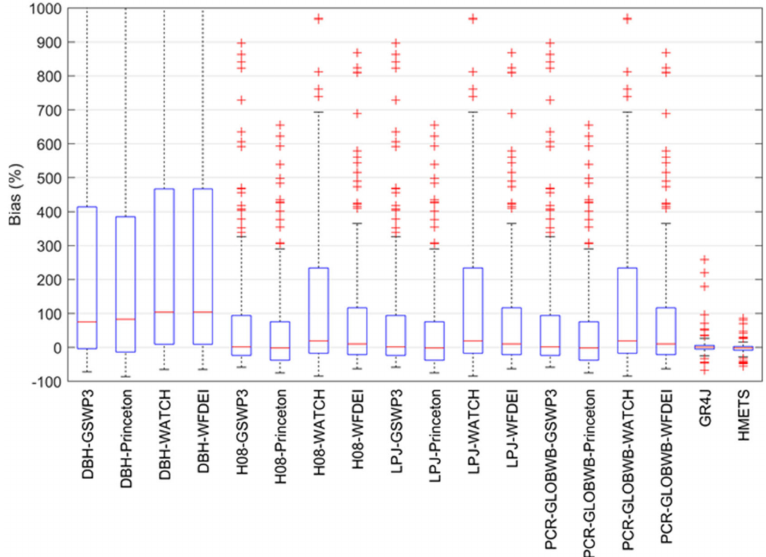
Figure 5. PBIAS (%) of the 16 gHM–climate–dataset combinations and rHMs used in this study. The red line in the box plots represents the median value; the ends of the boxes represent the 25th (lower) and 75th (upper) quantiles; outliers are shown as red crosses (+). Compared to the gHMs, both rHMs offer the best performance, with satisfactory bias values (PBIAS ≤ +25%) while decreasing the spread of the discharge